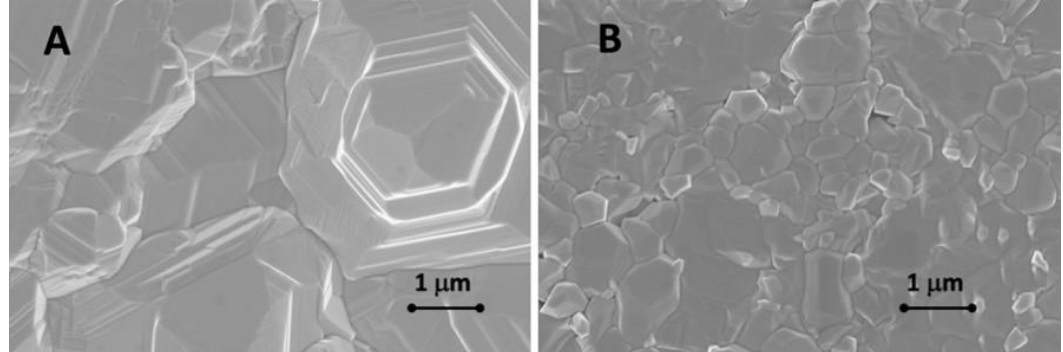
Figure 3. As deposited CdTe layers by CSS ( A ) and by vacuum evaporation ( B ).